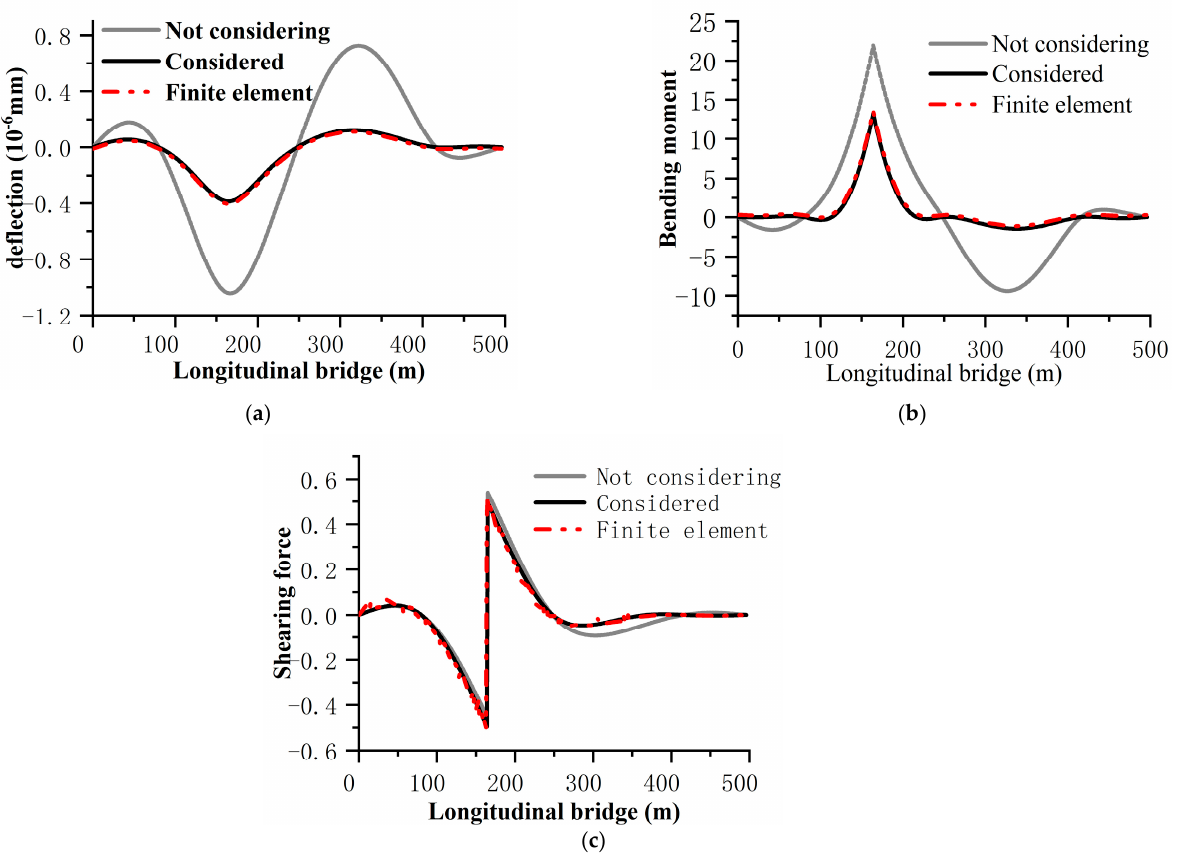
Figure 7. Internal force and deformation influence line of middle section of left main span. ( a ) Deflection influence line. ( b ) Bending moment influence line. ( c ) Shear influence line.